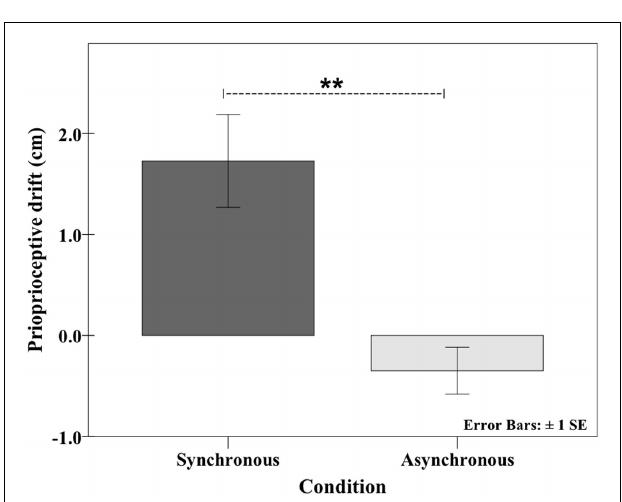
FIGURE 2 | Questionnaire data showing the average ownership and agency ratings on a 7-point Likert scale. The senses of ownership and agency were present (both > 1) in the synchronous condition but not in the asynchronous condition.The ownership and agency statement scores (the means of the four statements related to ownership and agency, respectively)